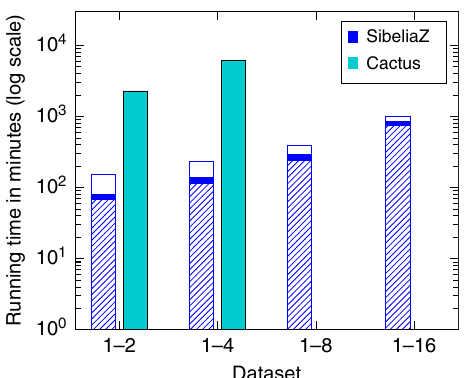
Fig. 3 Running times of the different pipelines on the mice datasets (on a log scale). Each bar corresponds to a pipeline. The bar of SibeliaZ is split according to its components: spoa (hatch fi ll), TwoPaCo (solid fi ll), and SibeliaZ-LCB (empty fi ll). Cactus is not shown on datasets 1 – 8 and 1 – 16 because it did not complete. We used 32 threads for each experiment.